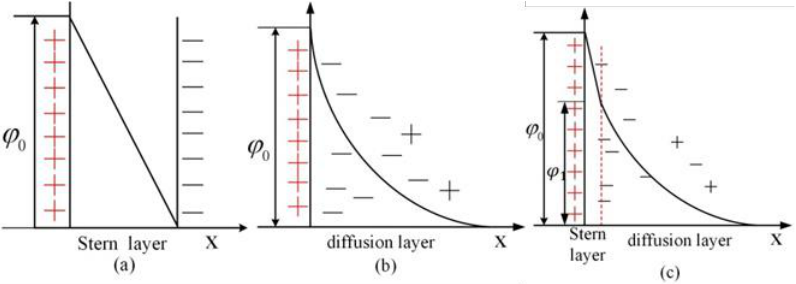
Figure 2. Structural of classic electric double layer (EDL) models. From left to right are the Helmholtz– Perrin ( a ) Gouy–Chapman model ( b ) and the Gouy–Chapman–Stern models ( c ), respectively. Table 1. Main mechanisms and the scope of application of the three classic interface models. EDL Model